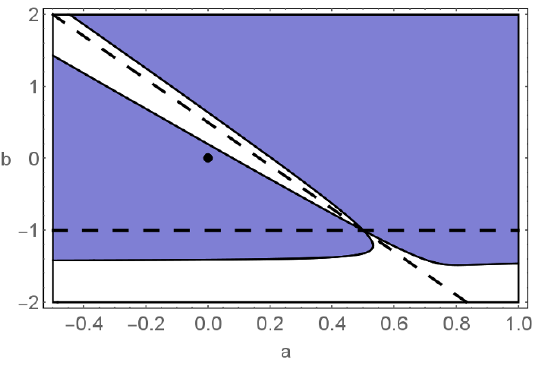
Figure 5 . The blue region indicates where the inequality (cid:0) f g = (cid:17) A j grav < 0, is satis(cid:12)ed. The dashed lines indicate the poles 1 + b = 0 (TT-mode) and 1 (cid:0) 6 a (cid:0) 2 b = 0 ( (cid:27) -mode).